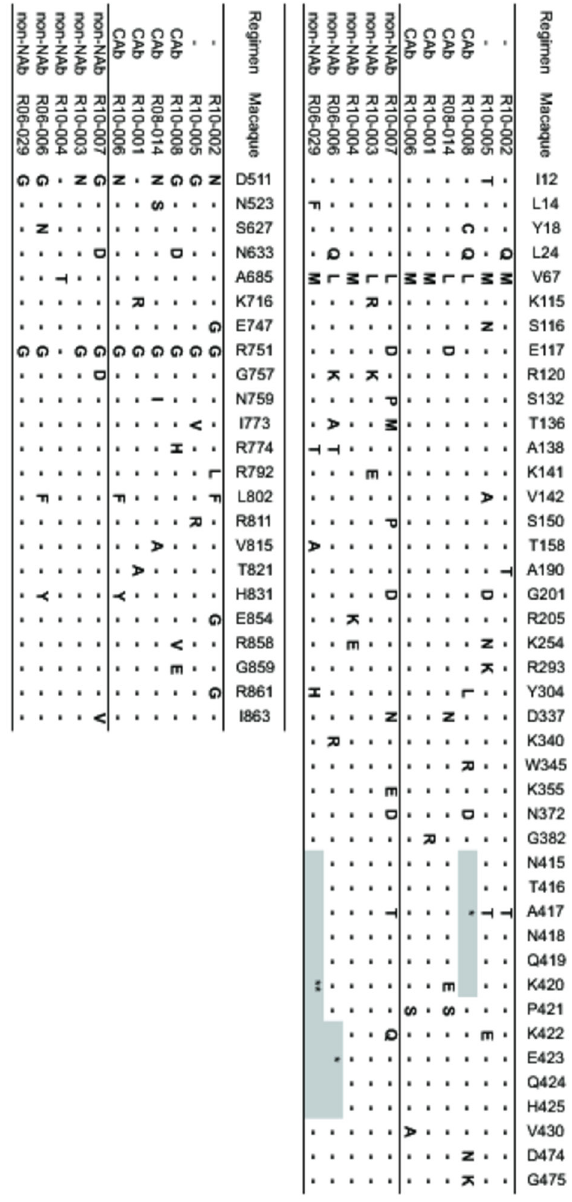
Figure 6. Predominant nonsynonymous env mutations. Viral cDNAs encoding Env were amplified from plasma RNAs obtained at 7-9 months (R10-001, R10-004, and R06-029) or 12 months (other animals) and subjected to sequencing analysis. Amino acid substitutions are shown. The asterisk (*) represents a deletion and the double asterisk (**) represents coexistence of multiple deletion patterns. doi: non-NAb immunization does not influence primary SIV replication when administered at early post-infection. In agreement with the limited protective effect observed when non-NAbs were administered locally on mucosa before virus